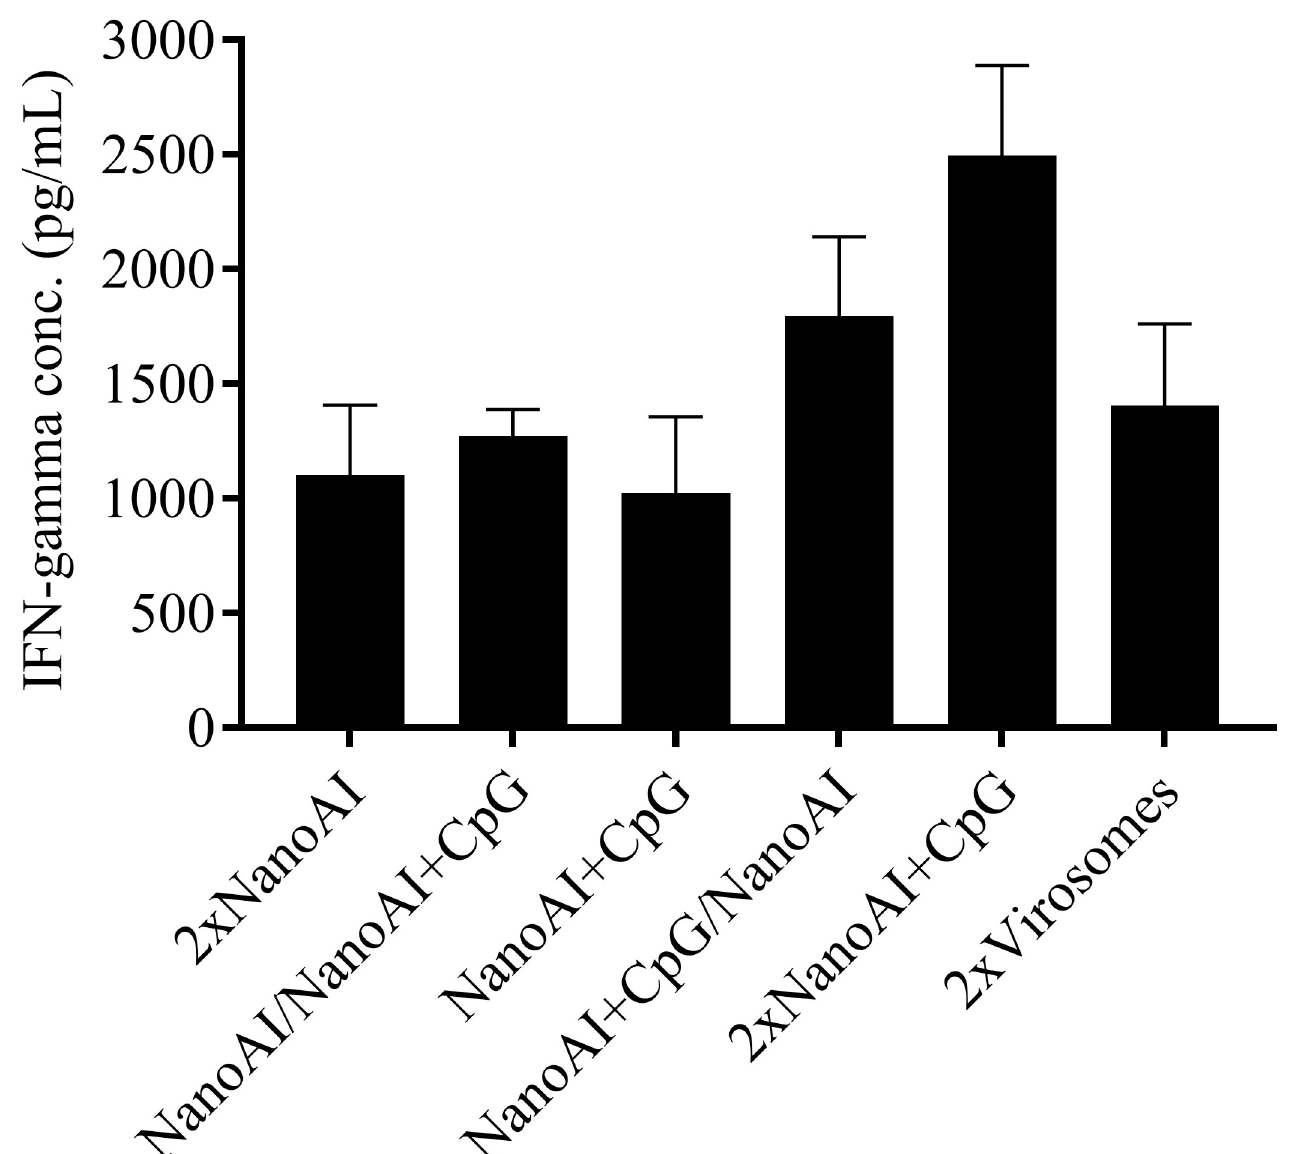
Fig 3. Evaluation of IFN- γ production by in vitro stimulated splenocytes with heat killed AIV. Splenocytes were harvested on day 35 post-primary vaccination from SPF chickens immunized subcutaneously with PLGA NPs based AIV vaccines and virosomes. They were stimulated with heat killed AIV (100 ng/well) for 72 hr and IFN- γ was measured in the cell supernatants. Results represent mean ± SEM. P < 0.05 was considered significant.